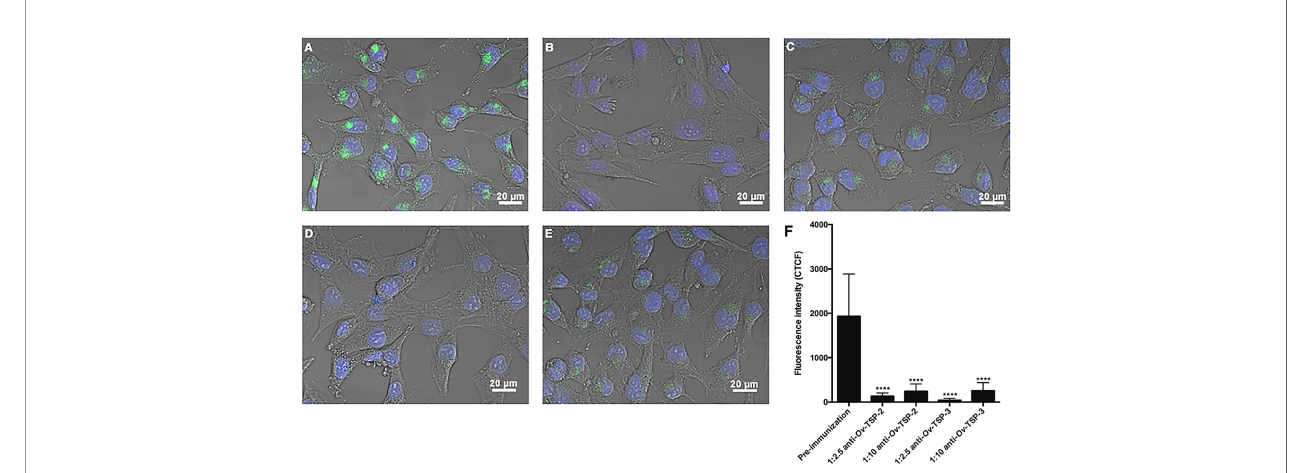
FIGURE 4 | Antisera against recombinant Ov -TSP-2 and Ov -TSP-3 blocked the uptake of O. viverrini 120k extracellular vesicles by cholangiocytes. H69 human cholangiocytes were cultured with PKH67-labeled O . viverrini 120k extracellular vesicles (EVs) in the presence of rabbit pre-immunization serum (A) , rabbit antiserum to recombinant Ov -TSP-2 at dilutions of 1:2.5 and 1:10 (B, C) , rabbit antiserum to recombinant Ov -TSP-3 at dilutions of 1:2.5 and 1:10 (D, E) . Corrected total cell fl uorescence was measured at 490 nm (green channel) using ImageJ (F) . The nuclei were stained by Hoechst (blue color). Thirty cells were counted form 3 random microscope fi elds for each sample in 2 independent experiments. Values are mean ± SD. The corresponding p-values ( ****P < 0.0001) were obtained by one-way ANOVA with Tukey-Kramer post-hoc multiple comparison test.